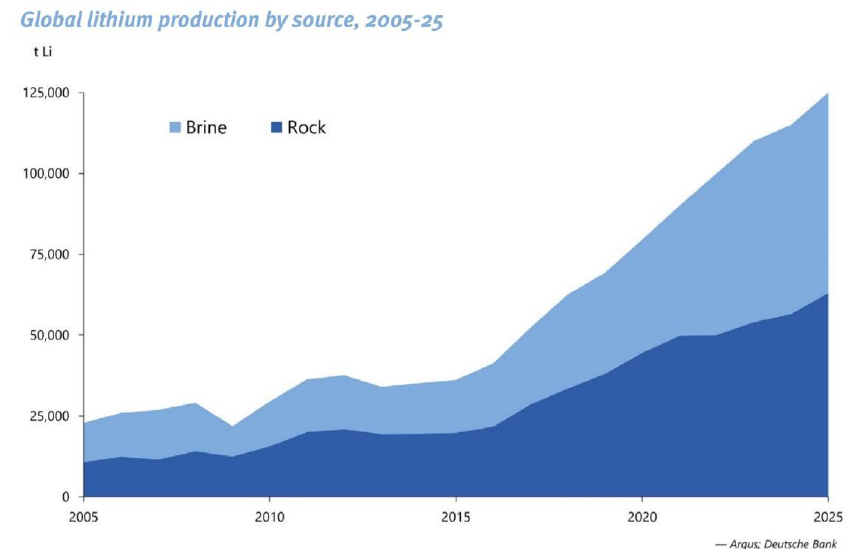
Figure 3. Distribution of worldwide Li production from brine and hard rock sources [16]. Brines are expected to become an increasingly important source of lithium. Reproduced with permission from Argus Media Ltd.